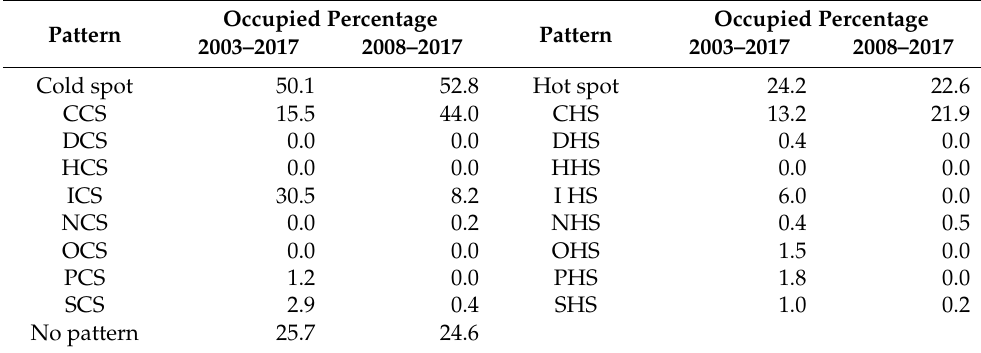
Figure 8. Distribution and pa tt ern of landslide spatiotemporal hot spots in the 2003–2017 and 2008– 2017 landslide models. Table 4. Occupied percentage of landslide spatiotemporal hot spots and cold spots in 2003–2017 and 2008–2017 in Taiwan.